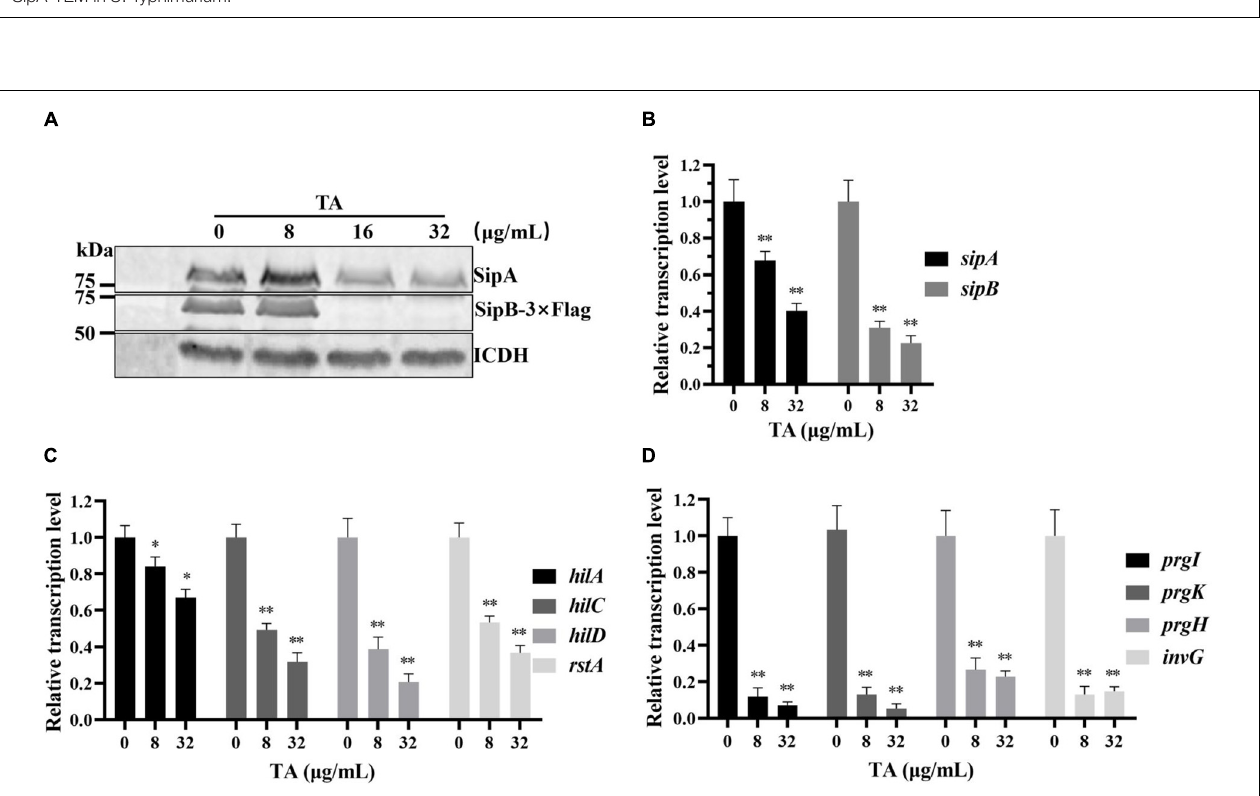
FIGURE 4 | Tannic acid inhibits the expression of T3SS effector proteins by inhibiting the transcription of key SPI-1 genes. (A) The effect of TA on chromosomally expression of sipA and sipB genes by WB analysis. (B) The effect of TA on transcription of sipA and sipB genes by RT-PCR. (C) The effect of TA on transcription of regulatory genes by RT-PCR. (D) The effect of TA on transcription of structural genes of T3SS by RT-PCR ( ∗ p < 0.05, ∗∗ p < 0.01).